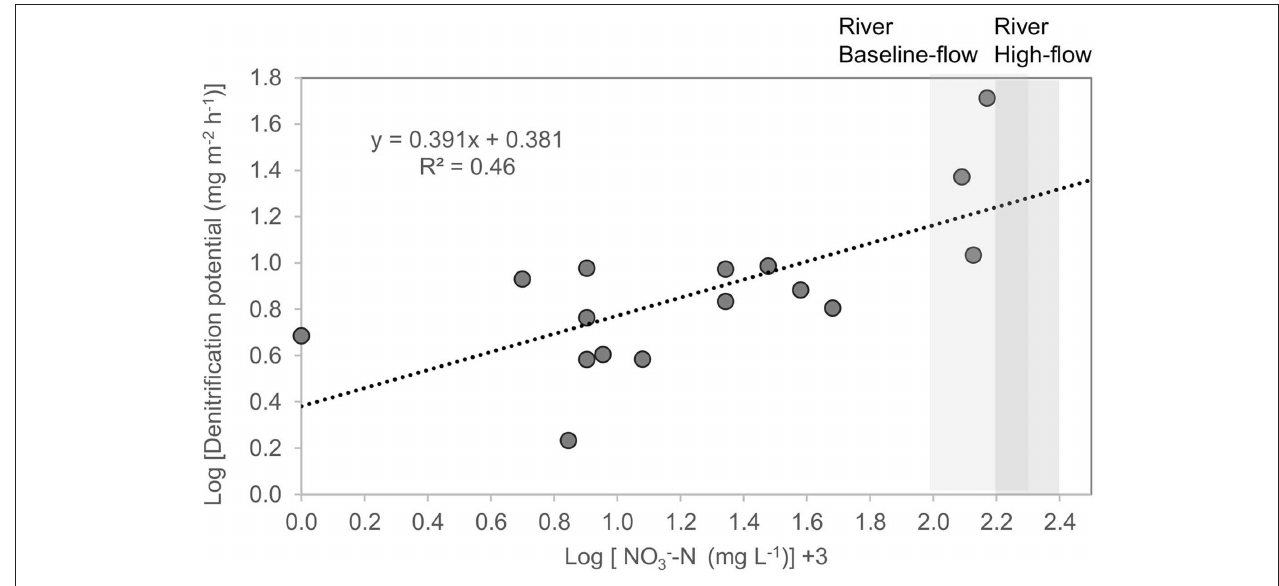
FIGURE 3 | Denitrification potential [log] (mg m − 2 h − 1 ) of coastal wetlands (mangroves, Melaleuca spp. wetlands, saltmarsh, waterbodies with macrophytes) vs. NO − 3 -N concentration in the floodwater [log + 3] (mg L − 1 ). Data from Melaleuc a spp. wetlands has been previously been published in Adame et al. (2019b). Ranges of NO − 3 -N concentrations during baseline and high flows for the Tully River are shown as shaded areas ( Orr et al., 2014).